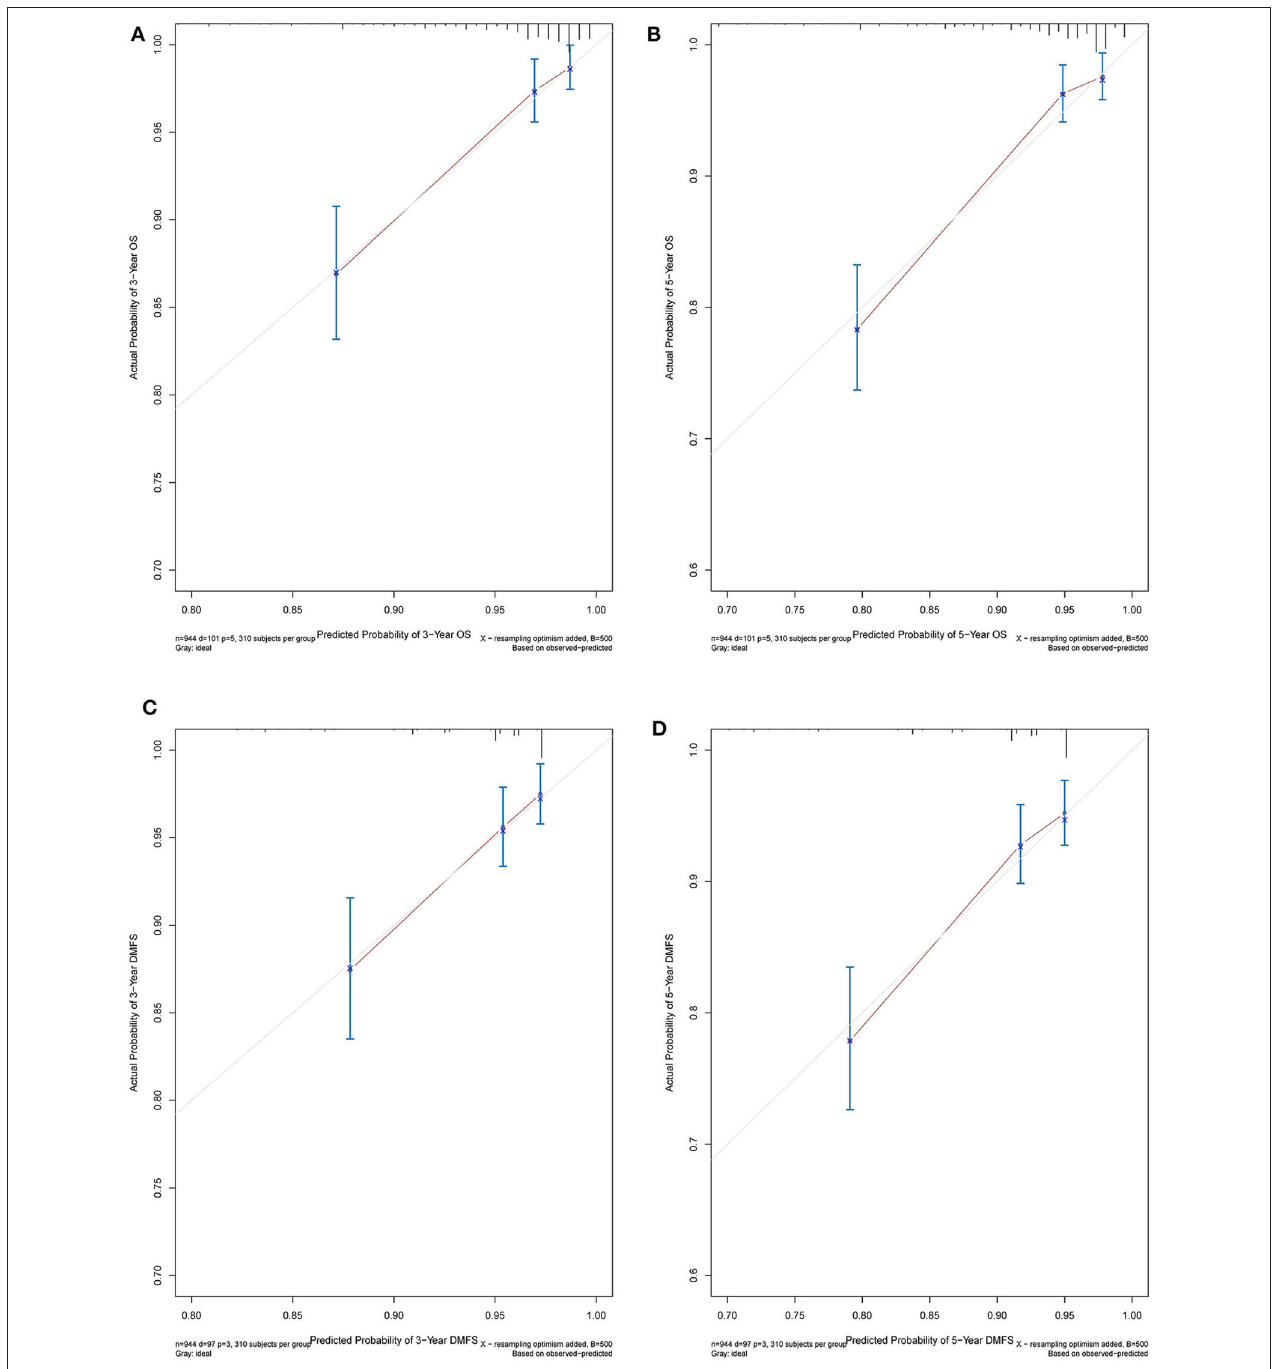
FIGURE 4 | Nomogram model calibration curves of 3-year (A) and 5-year (B) overall survival, and 3-year (C) and 5-year (D) disease metastatic free survival in the training cohort.